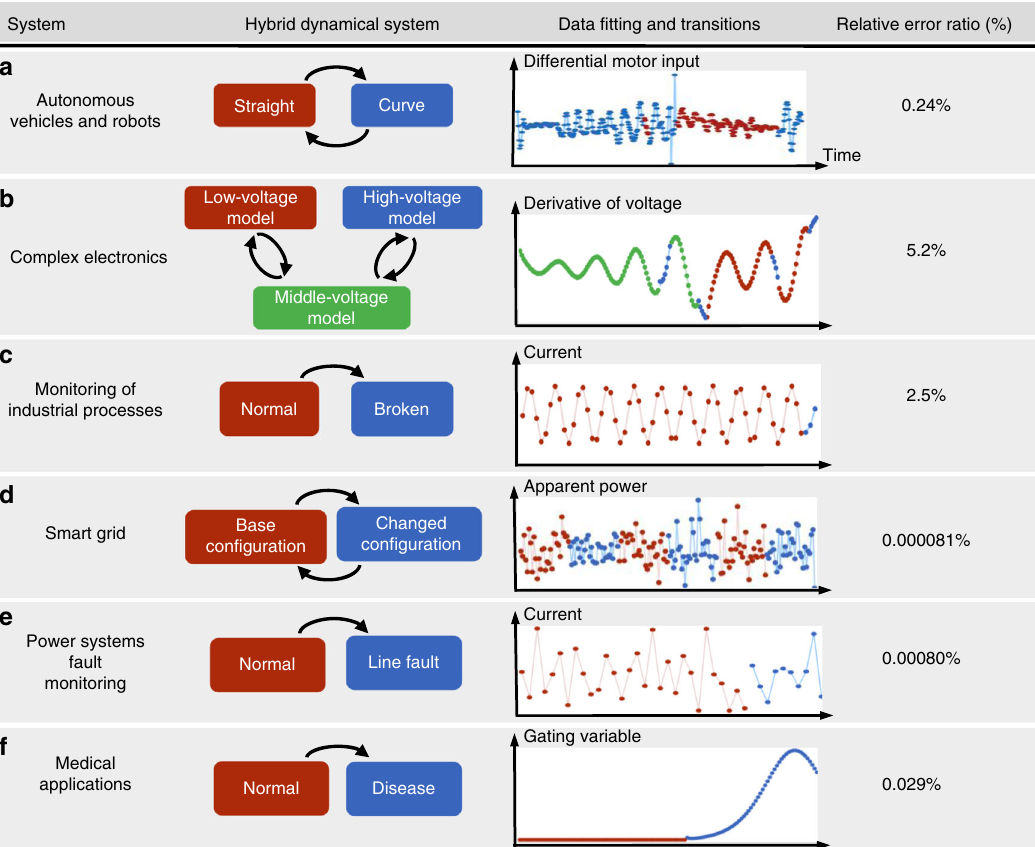
Fig. 2 Summary of IHYDE algorithm applied to numerous examples. IHYDE has been applied to six examples in different applications. The fi rst column illustrates the systems, while the second column shows the different subsystems plus the transition rules. Each subsystem is associated with a particular color. The third column shows the original time-series data (dots) in the color associated with the subsystem that generated it, the fi tted data from the identi fi ed models (lines connecting the dots), and the location of the transitions (changes in colors). The last column presents the relative error ratio 31 between the true data and the data simulated by the fi tted model. A small error ratio indicates a good agreement between the true and discovered systems, and serves as a measure of the performance of